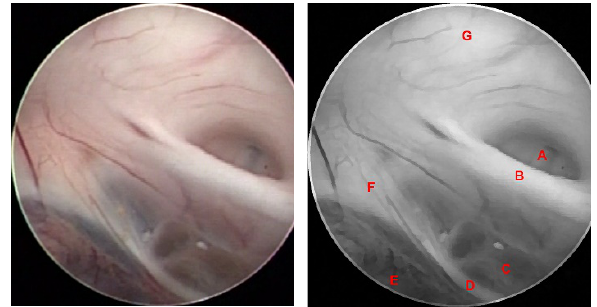
Fig. 19. Cerebral aqueduct entrance (A), posterior commissure (B), pineal recess and pineal gland (C), habenular commissure (D), suprapineal recess (E), habenular trigone (F), left thalamus